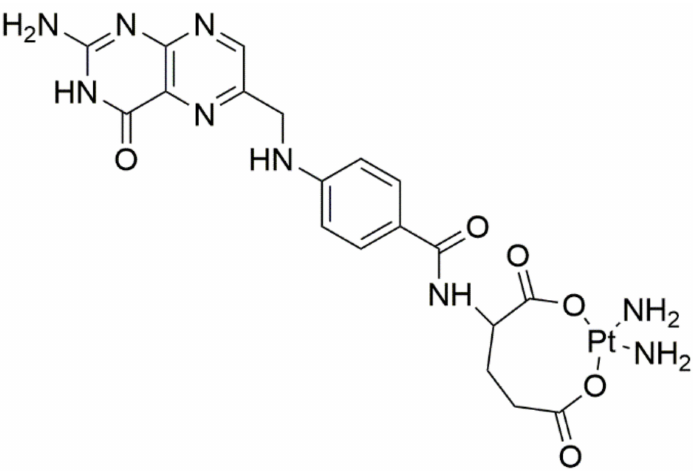
Figure 8. Novel platinum complex with folic